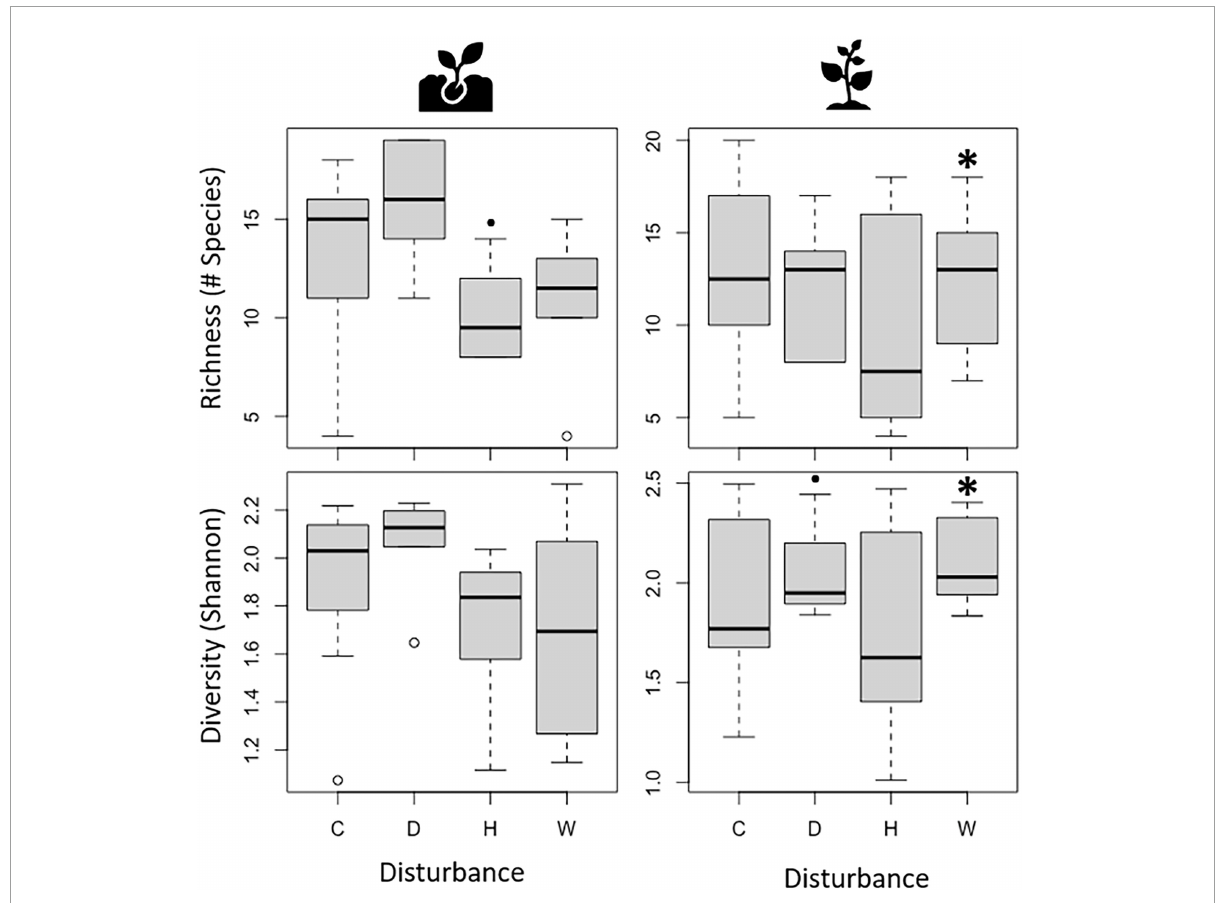
FIGURE2 Richness (number of species) and Diversity (Shannon’s diversity index) of seedlings (Left) and saplings (Right) during control (C), drought (D), hurricanes (H), and warming (W). Black asterisks above bars denote significant differences from the control at α = 0.05, while black filled circles denote significant differences at α = 0.1 resulting from Linear Mixed